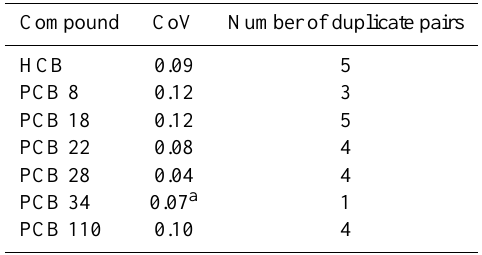
Table 2. Overall method precision, expressed as the non-parametric coefficient of variation (CoV) of field duplicates, using the same de- nuder sampling method as in the 14 July 2006 measurements (Rowe and Perlinger, 2009a).